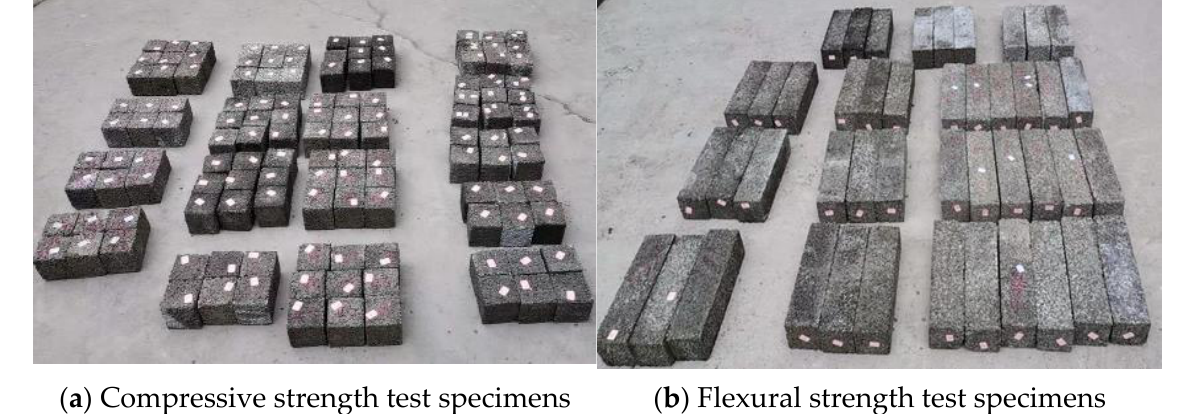
Figure 2. Compressive and flexural strength test schemes.